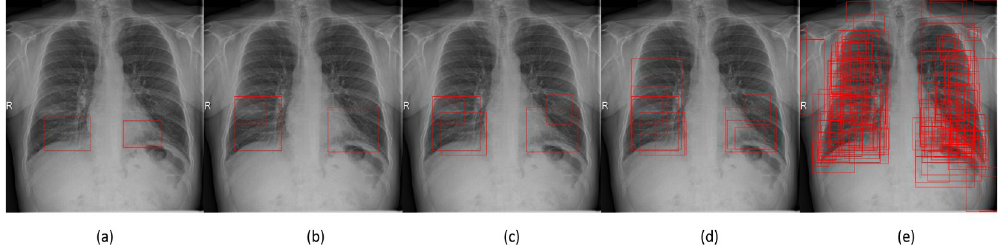
Fig 7. Results of opacity localisation: (a) Ground Truth (b) WBF Top 3 Bounding Boxes (c) WBF Top 5 Bounding Boxes (d) WBF Top 10 Bounding Boxes (e) WBF All Bounding Boxes with lowered threshold.